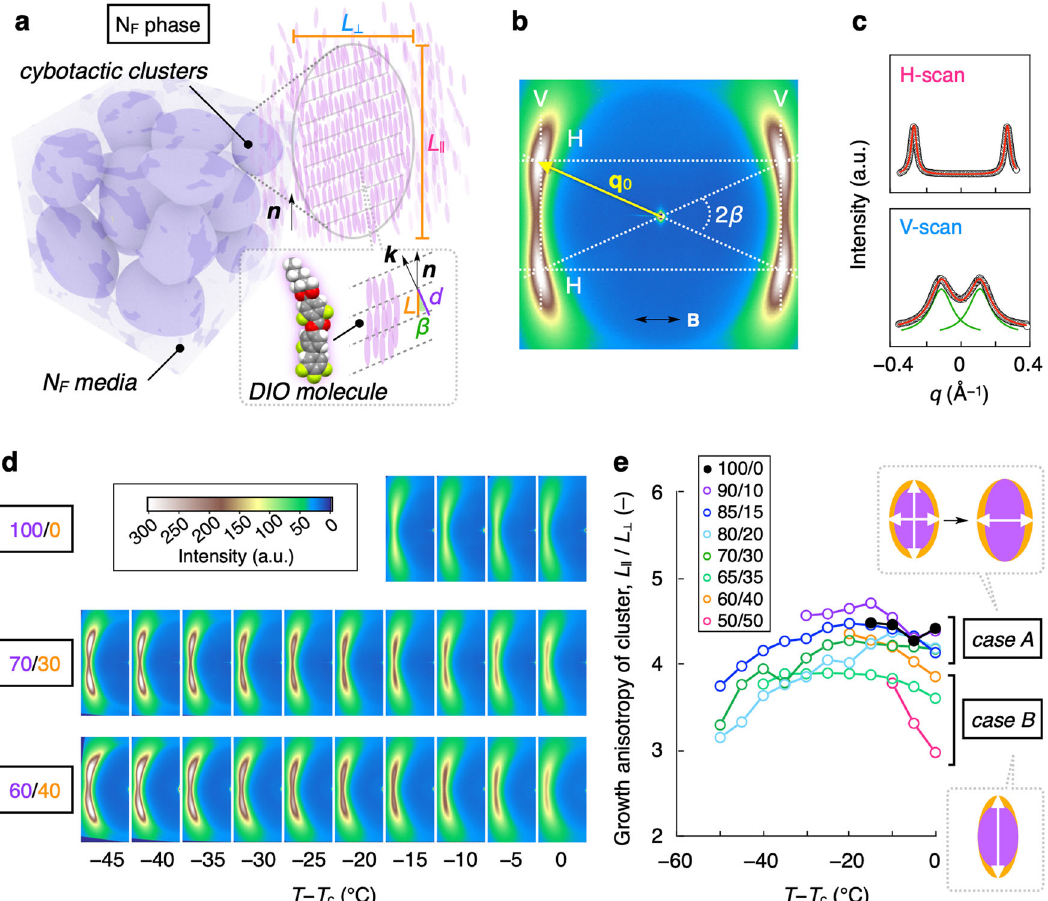
Fig. 3 Characterization of the cybotactic clusters in the diastereomeric-controlled N F phase. a Schematic illustration of the N F phase of 1 or 1 / 2 mixture. L ‖ and L ⊥ are longitudinal and transversal dimension of the cybotactic cluster, respectively. L , d , β denote the molecular length, d -spacing between layers and tilt angle, respectively. b Small-angle X-ray scattering pro fi le. A white-colored arrow denotes the direction of the applied magnetic fi eld. The symbols are de fi ned in the text. c The horizontal (H) and vertical (V) scans of the four-spot pattern along the H-/V-dash lines indicated in the panel b . Intensity pro fi les I( Δ q ‖ ) (upper) and I( Δ q ⊥ ) (bottom) of the small-angle skewed spots measured via the maxima at q 0 long the longitudinal ( ‖ B ) and transversal ( ⊥ B ) direction, respectively. d Evolution of the skewed peaks of the 1 / 2 mixture with dr = 100/0, 70/30 and 60/40, as a function of the temperature, T − T dr , and its temperature-dependent. Inset cartoon depicts the two variation (case A and c . e The relationship between growth anisotropy of cluster and case B) of the growth of the cybotactic cluster in the N F